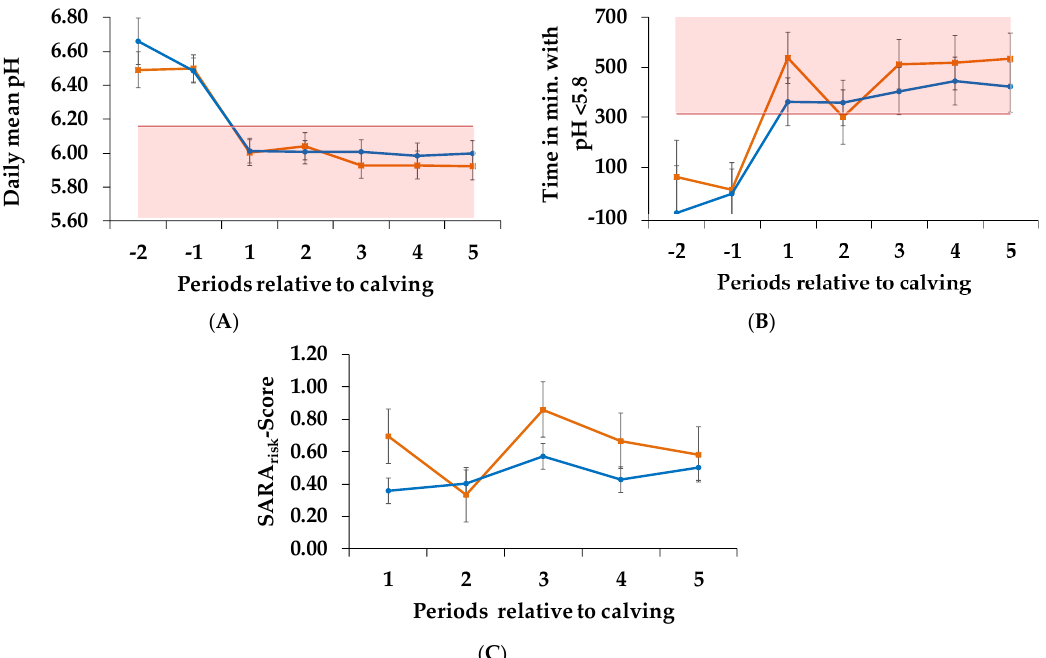
Figure 2. Daily mean pH of the rumen ( A ), time per day with pH < 5.8 ( B ) from week 3 antepartum until week 10 postpartum; red areas indicate SARA risk. Statistical analysis started at calving (period 1: weeks 1 – 2 postpartum, period 2: weeks 3 – 4 postpartum, period 3: weeks 5 – 6 postpartum, period 4: weeks 7 – 8 postpartum and period 5: weeks 9 – 10 postpartum) and SARA risk -Score (C) was calculated as quotient of the sum of the number of positive observations per cow in period i and total number of observations per cow in period i divided by total number of cows assessed in period i , during period 1–5 in the treatment groups. After calving, cows were assigned to a group with 60% concentrate feed proportion (increasing from 35 to 60% during the first three weeks after parturition, C 60 , orange , n = 6) and a group with 35% concentrate feed proportion ( C 35 , blue , n = 7) in the ration. Table 3. p -values of effects of concentrate proportion of the diet (C), period and the interaction between them on daily mean pH and time in minutes with pH < 5.8. p -Values C Period § C × Period (A) Daily mean pH 0.700 0.506 0.724 (A) Time in min. with pH < 5.8 0.557 0.205 0.545